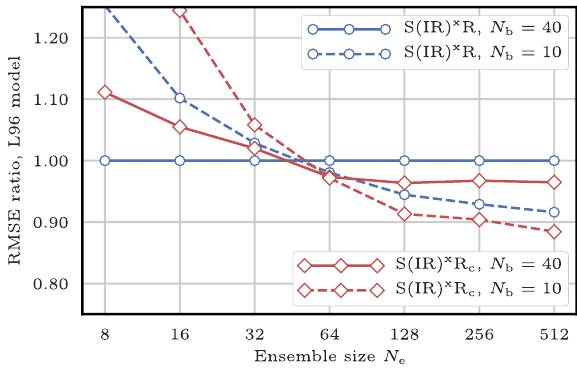
Figure 12. RMSE as a function of the smoothing radius r s for the S(IR) x S PM R algorithms with N e = 16 particles and N b = 40 blocks of size 1 grid point for several values of the smoothing strength α s . The scores are displayed in units of the RMSE of the S(IR) x R algorithm with N e = 16 particles and N b = 40 blocks of size 1 grid